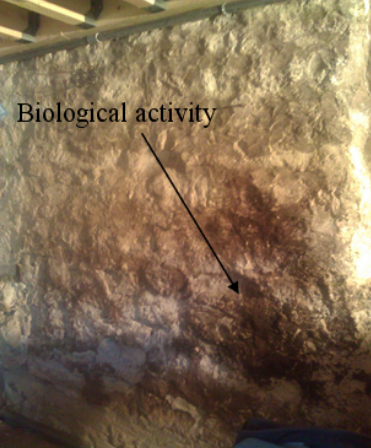
Figure 7. Moist wall with development of the biological activity.